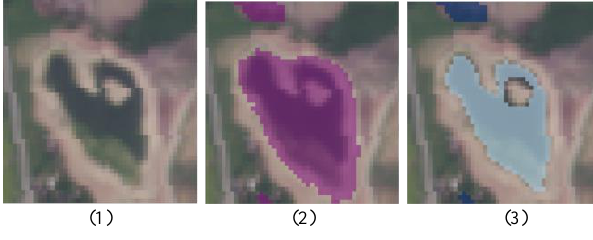
Figure 8: (1) Mosaic image over Denmark with the corresponding (2) multi-date water body extraction in purple and (3) the final result fitting the image in light